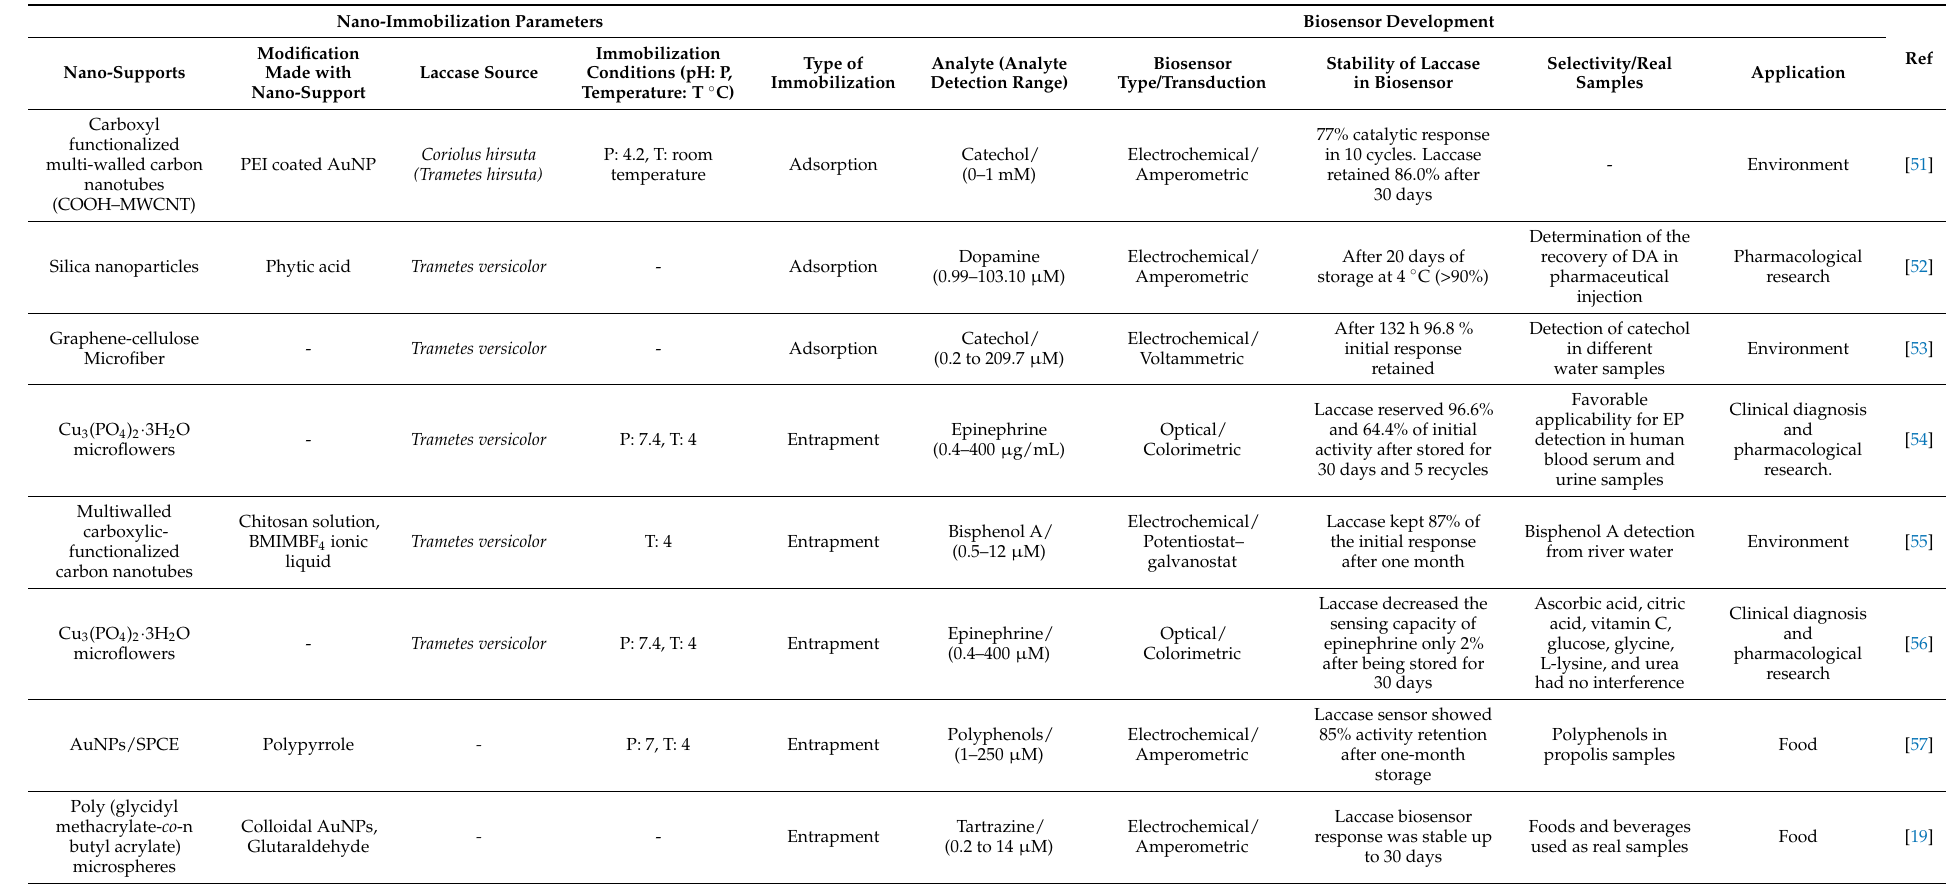
Table 1. The details of nano-immobilization processes and biosensor parameters analyzed in recently developed laccase-based